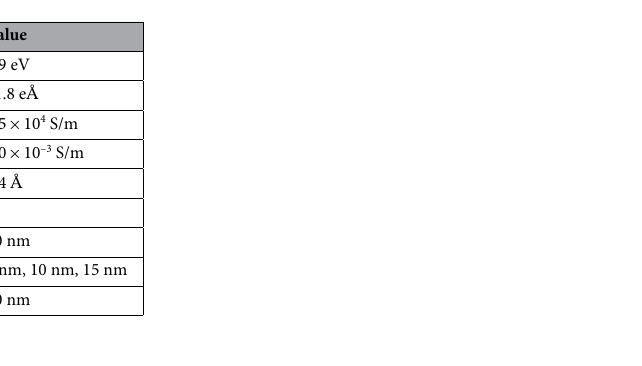
Table 1. Simulation